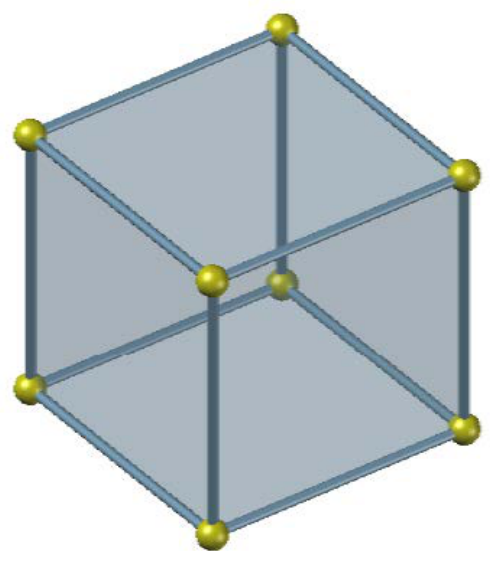
Figure 63: Cell-first perspective projection of the tesseract into 3 dimensions, with hidden surfaces culled.